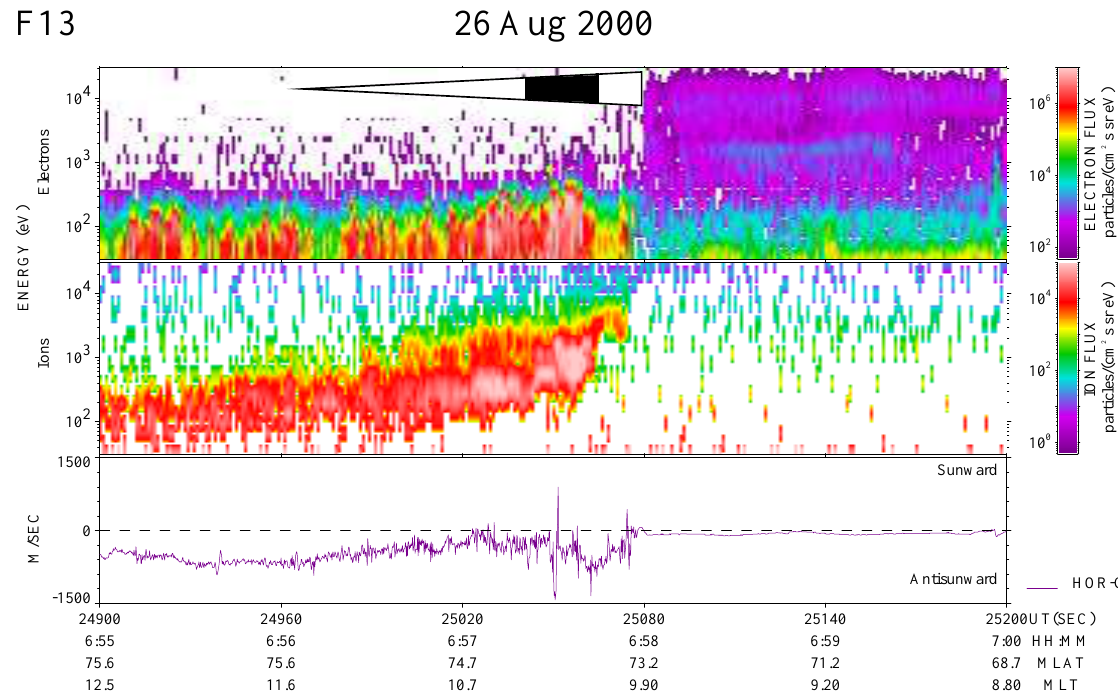
Fig. 7. Electron and ion flux spectra (upper two panels) and the horizontal component of cross-track ion drift (lower panel) for the pass of the DMSP F13 satellite between 06:55–07:00 UT. The extent of the ion dispersion is shown at the top of the electron spectra panel by the white triangle, consistent with Fig.